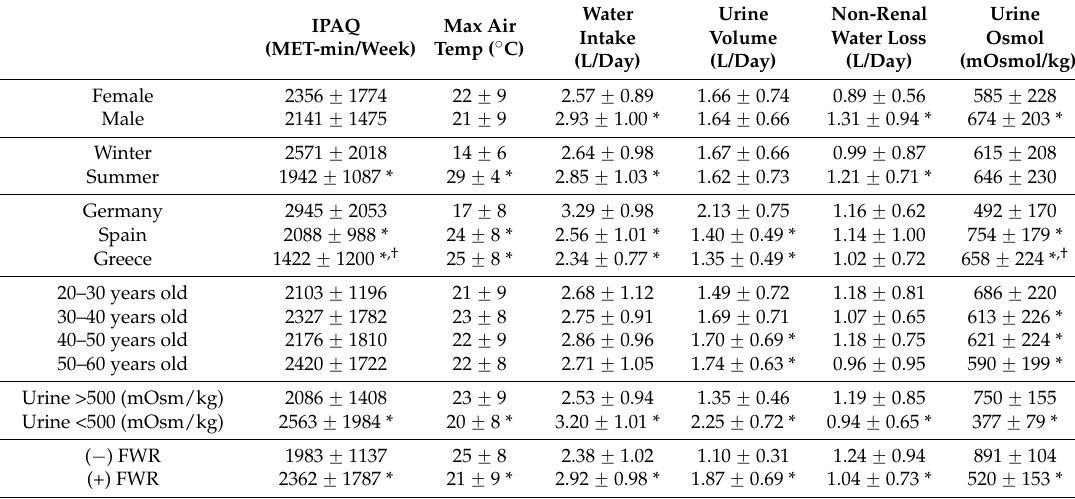
Table 1. Effects of gender, season, site, age group and hydration on physical activity and 24-h water intake/fluid